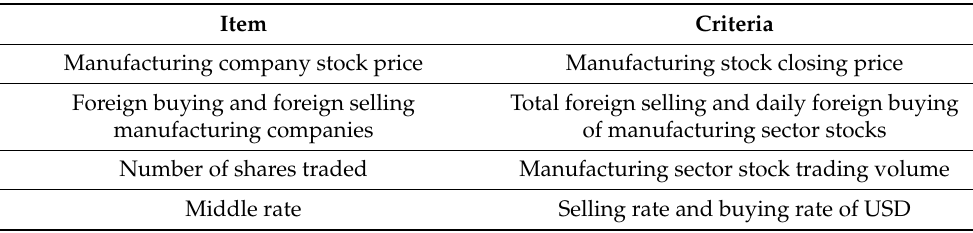
Table 1. Data Criteria.